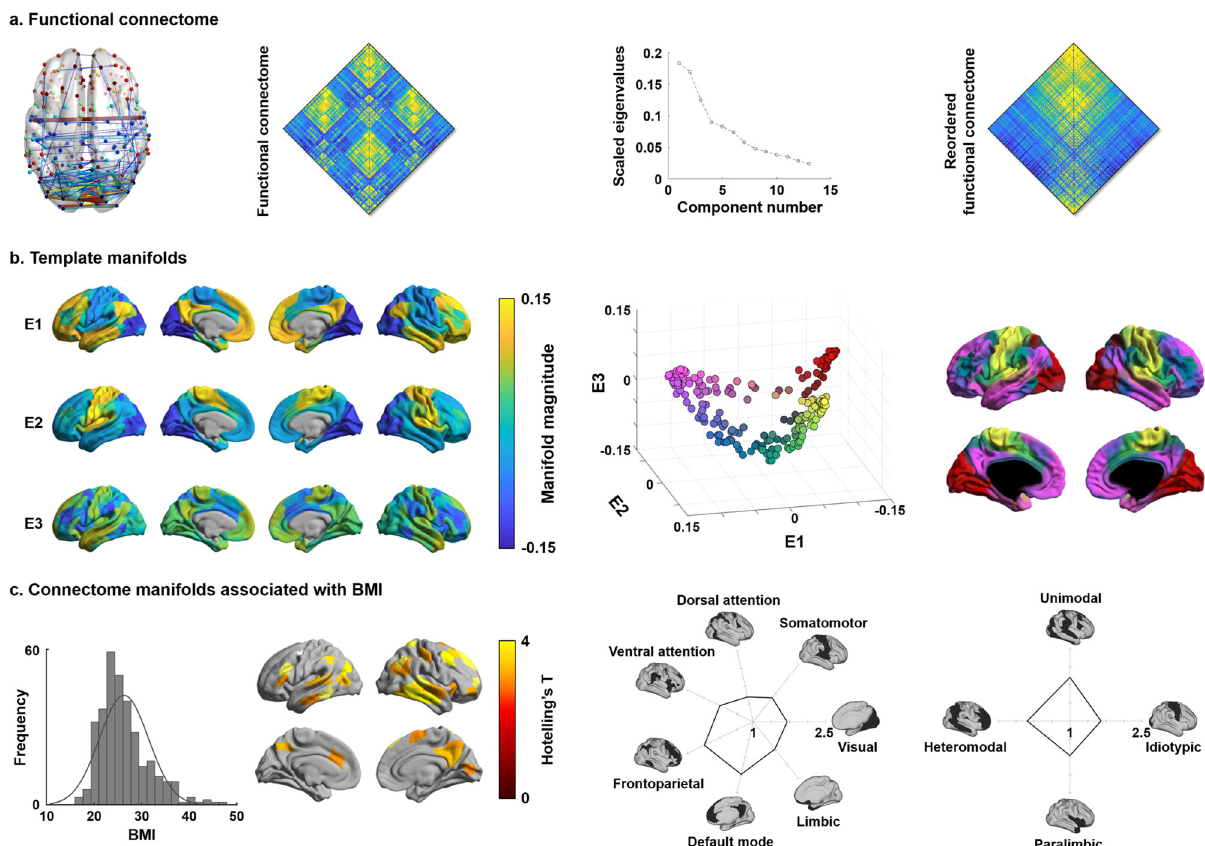
Fig. 1 Functional connectome manifolds. a A group averaged functional connectome in graph (left) and matrix representation (middle left), and a scree plot describing connectome information across functional components (middle right). The reordered functional connectivity matrix according to the fi rst eigenvector (i.e., E1) is shown on the right. b Template manifolds were built by three dominant eigenvectors (E1, E2, E3), based on the group averaged functional connectome (left). The scatter plot represents each brain region projected onto the three-dimensional manifold space with different colors (middle), also mapped to the cortical surface for visualization (right). c The distribution of BMI is reported on the left. Multivariate association highlighted regions showing signi fi cant associations between the three eigenvectors and inter-individual variations in BMI (middle left). Findings were corrected for multiple comparisons using a false discovery rate (FDR) < 0.05. Effects were strati fi ed according to intrinsic functional communities 72 (middle right) and levels of cortical hierarchy 46 (right), and shown in the spider plots. Source data are provided in Supplementary Data